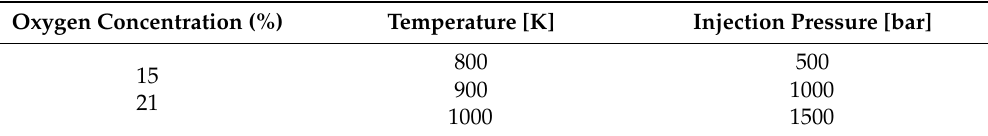
Table 3. Variation of parameters to evaluate for each